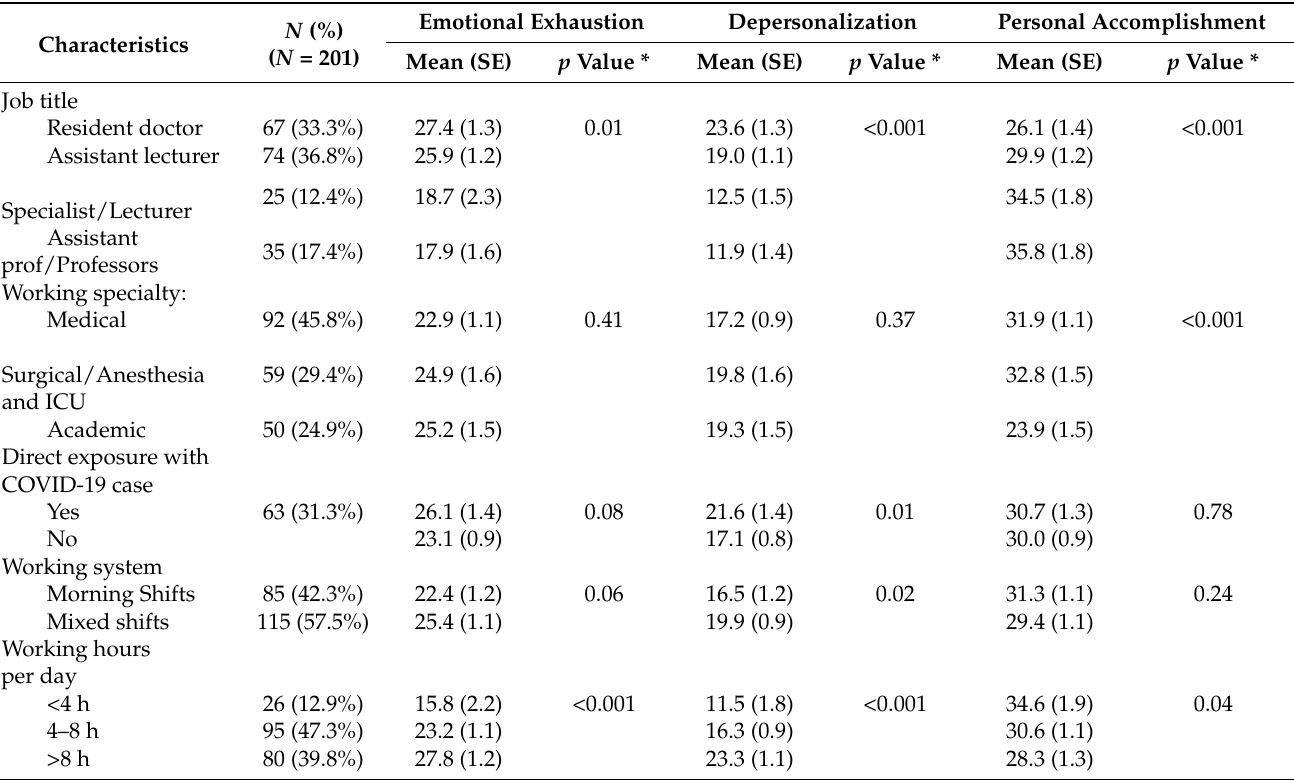
Table 3. Distribution of the doctors’ Maslach Burnout Inventory mean scores according to some workplace characteristics and COVID-19 case